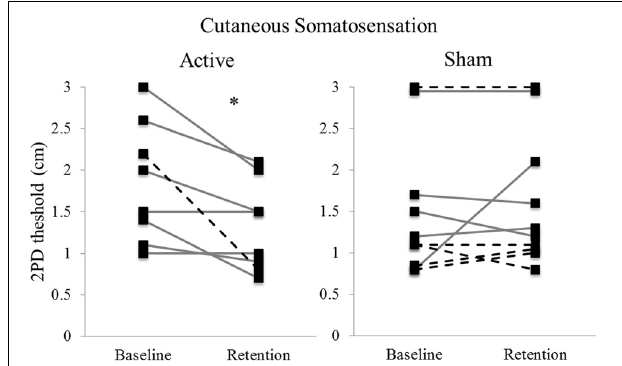
FIGURE 3 | Individual thresholds for 2-point discrimination at baseline and retention, by stimulation type. Lower values indicate better somatosensory discrimination (i.e., less distance between stimulation points). Solid lines indicate first time participation, dashed lines indicate second time (crossed over) participation. ( n = 8 Active; 10 Sham). ∗ p = 0 .